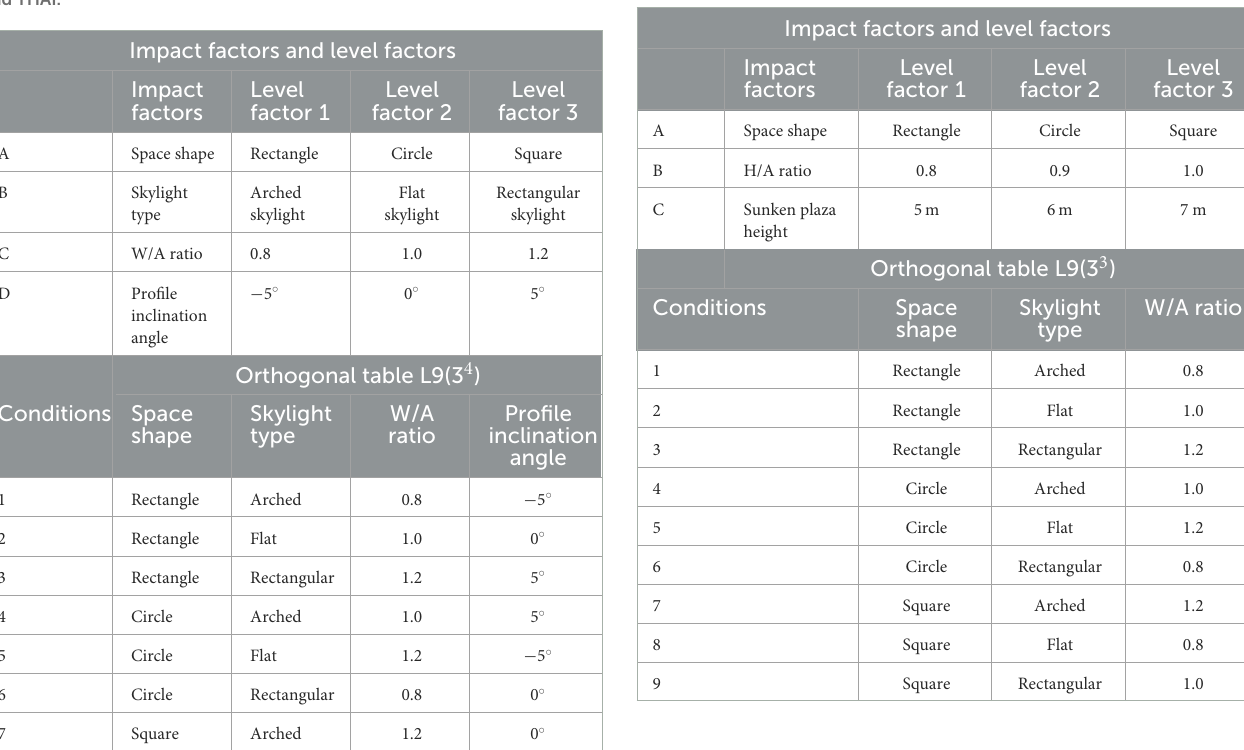
TABLE 4 Impact factors, level factors, and orthogonal table of